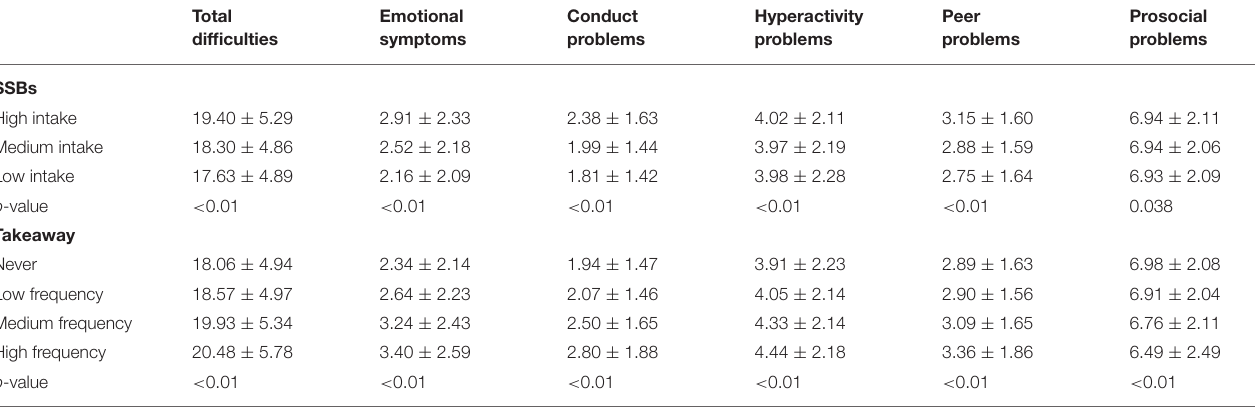
TABLE 3 | Scores on SDQ total difficulties and subscales, among sugar-sweetened beverages and takeaway.